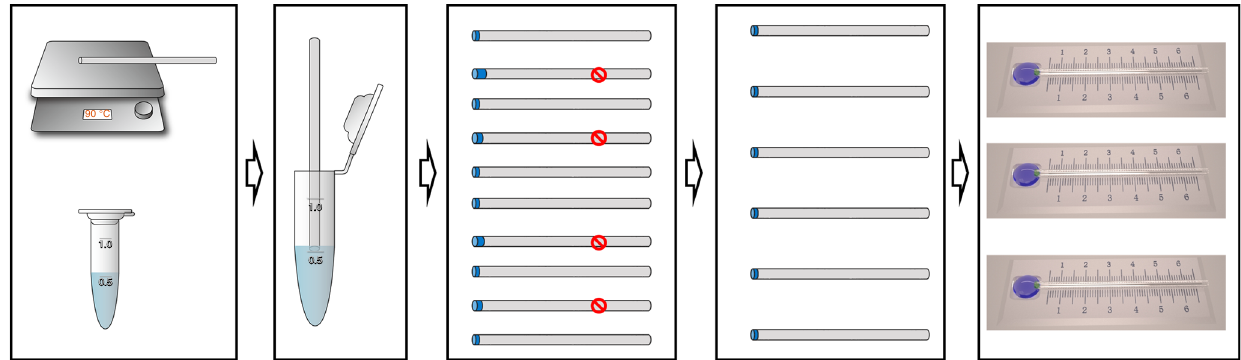
Fig. 2 The preparation process of the CSDR-Sensor. First, the DNA hydrogel is prepared, and then the capillary tube is placed on the 90 °C heating plate for 10 min. Second, the hot capillary tube is inserted vertically into the prepared DNA hydrogel, and is then lifted up after 3 s. Third, the gel fi lms in capillary tube with a thickness of 0.15 ± 0.01 mm are selected under the microscope. Finally, the capillary tube is fi xed on a scale substrate